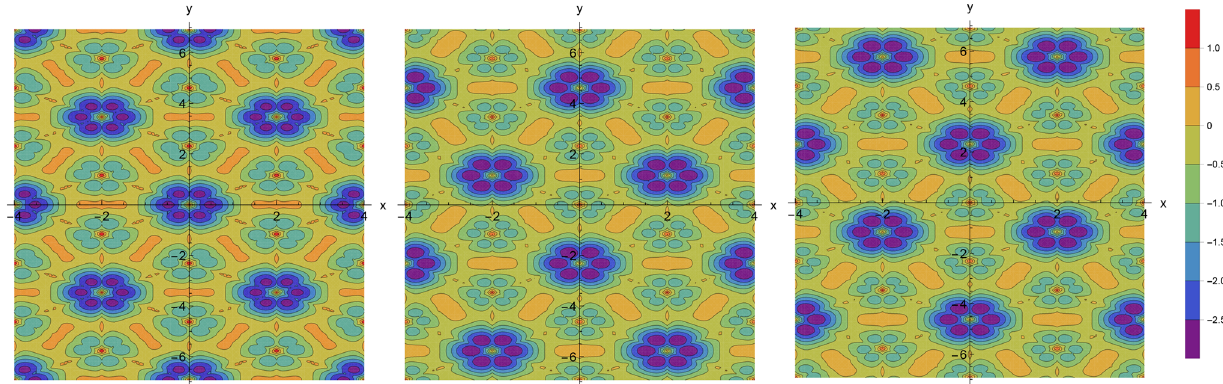
Fig. 6 Contour plot of the effective potential with imaginary chemical potential i μ for g = 4, N f = 3. The dependence on μ is periodic and the panels are made with equal spaced μ within one period, ˜ μ = 0, ˜ μ = 1